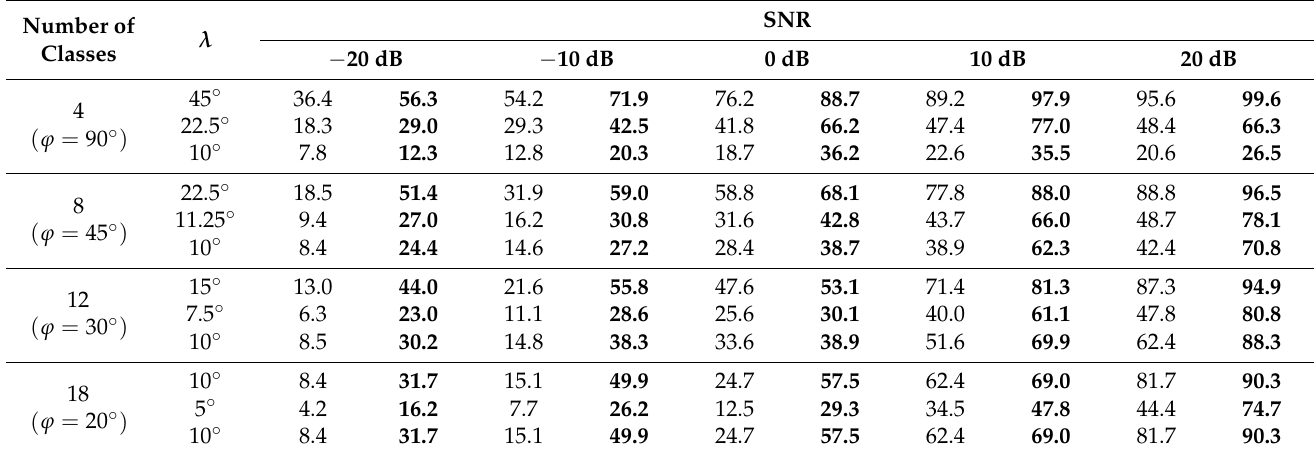
Table 3. Accuracies (%) for CO-DNNC and DNNC with varied SNRs and numbers of